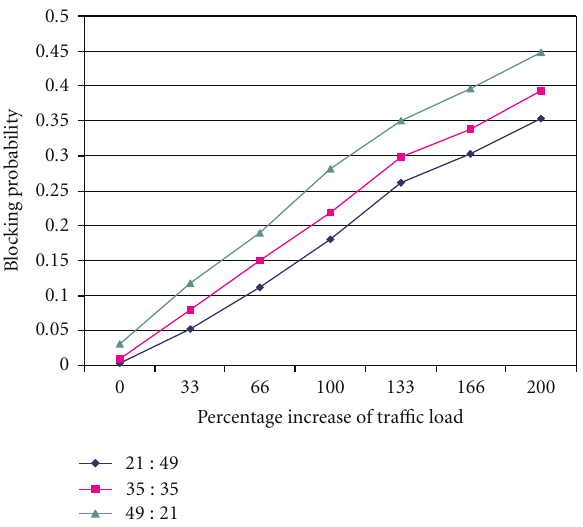
Figure 7: Performances with reassignment for g = 2 and w = 2.